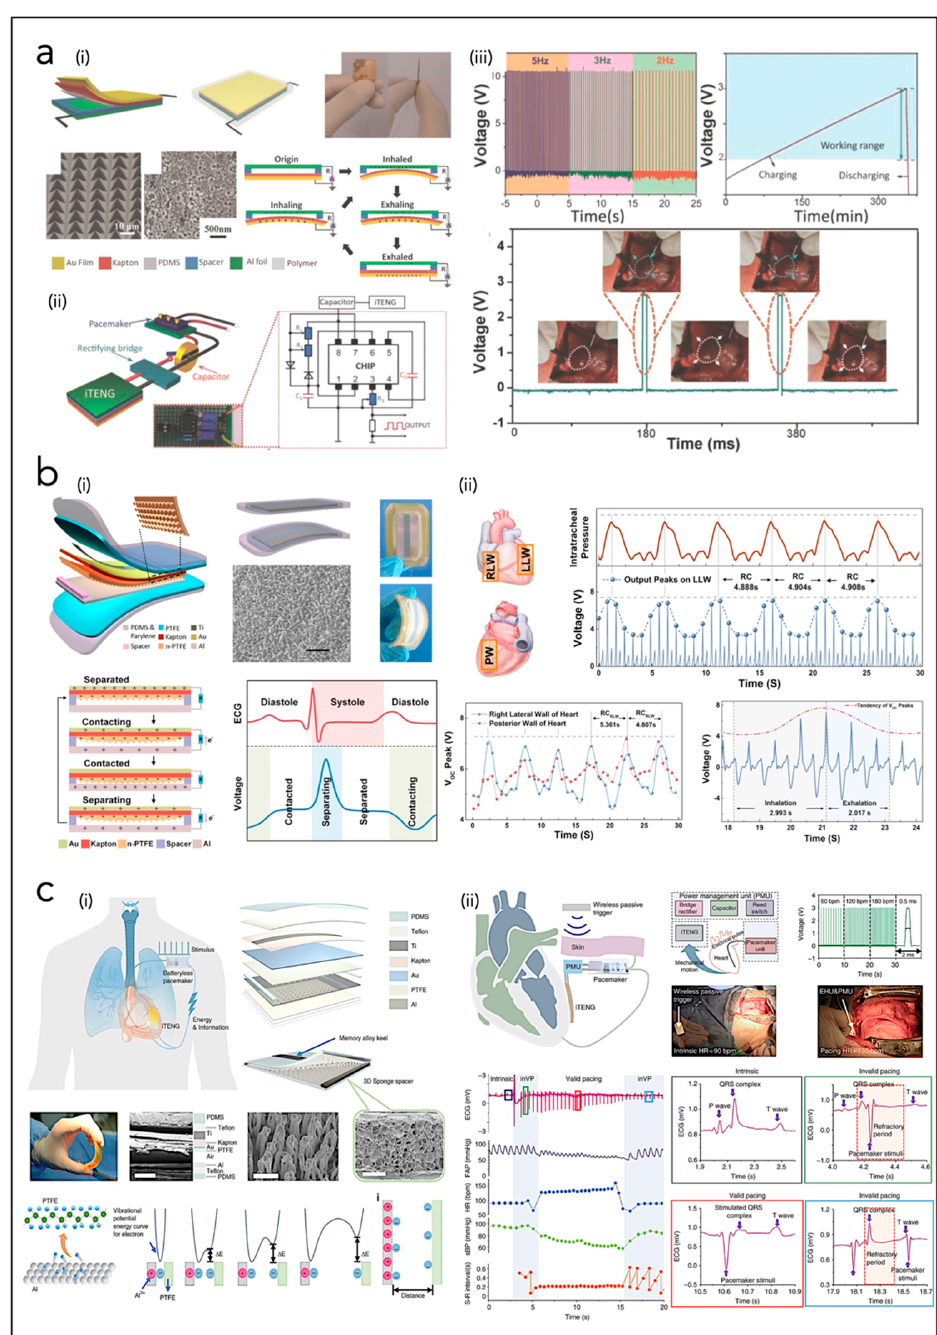
Figure 4. Examples of TNGs for heart energy harvesting. ( a ) Implantable TNG based on patterned PDMS (i) for powering a pacemaker (ii) to regulate the heartbeat in a rat (iii). Adapted with permission from reference [156], 2014 Copyright Wiley. ( b ) Implantable TNG based on nanostructured PTFE triboelectric layer (i) for energy harvesting from the heartbeat in different implanting sites: lateral wall (LLW), right lateral wall (RLW), and posterior wall (PW) of the heart (ii). Adapted with permission from reference [157], 2016 Copyright American Chemical Society. ( c ) Symbiotic cardiac pacemaker system based on implantable TNG made of nanostructured PTFE and 3D elastic sponge structure (i); (ii) illustration of the pacemaker turned on by wireless passive trigger in vivo in a pig model, with the ECG of successful pacing. Adapted from reference [158]. Creative Commons Attribution 4.0 International